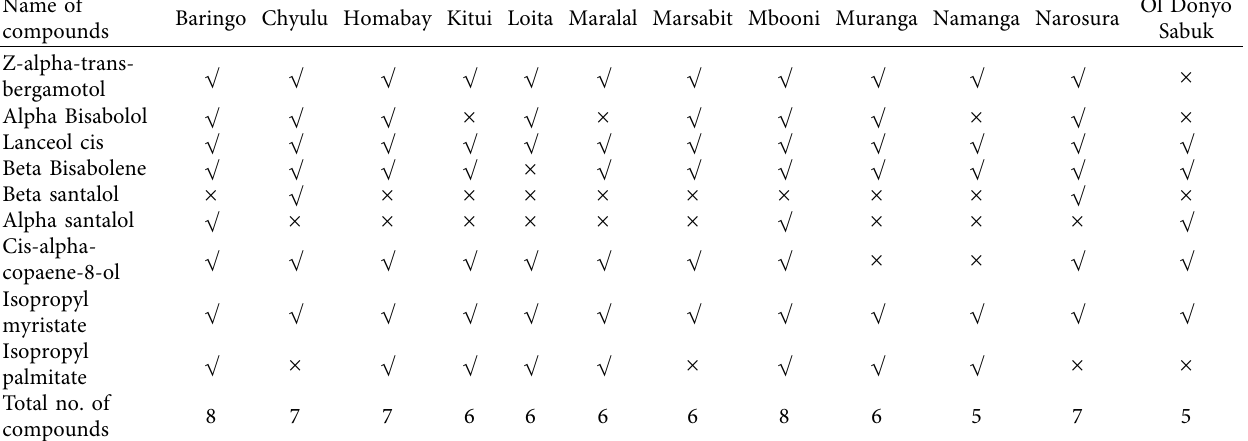
Table 5: Te relative presence of common compounds in oil extracts from 12 Sandalwood provenances in Kenya. Name of compounds